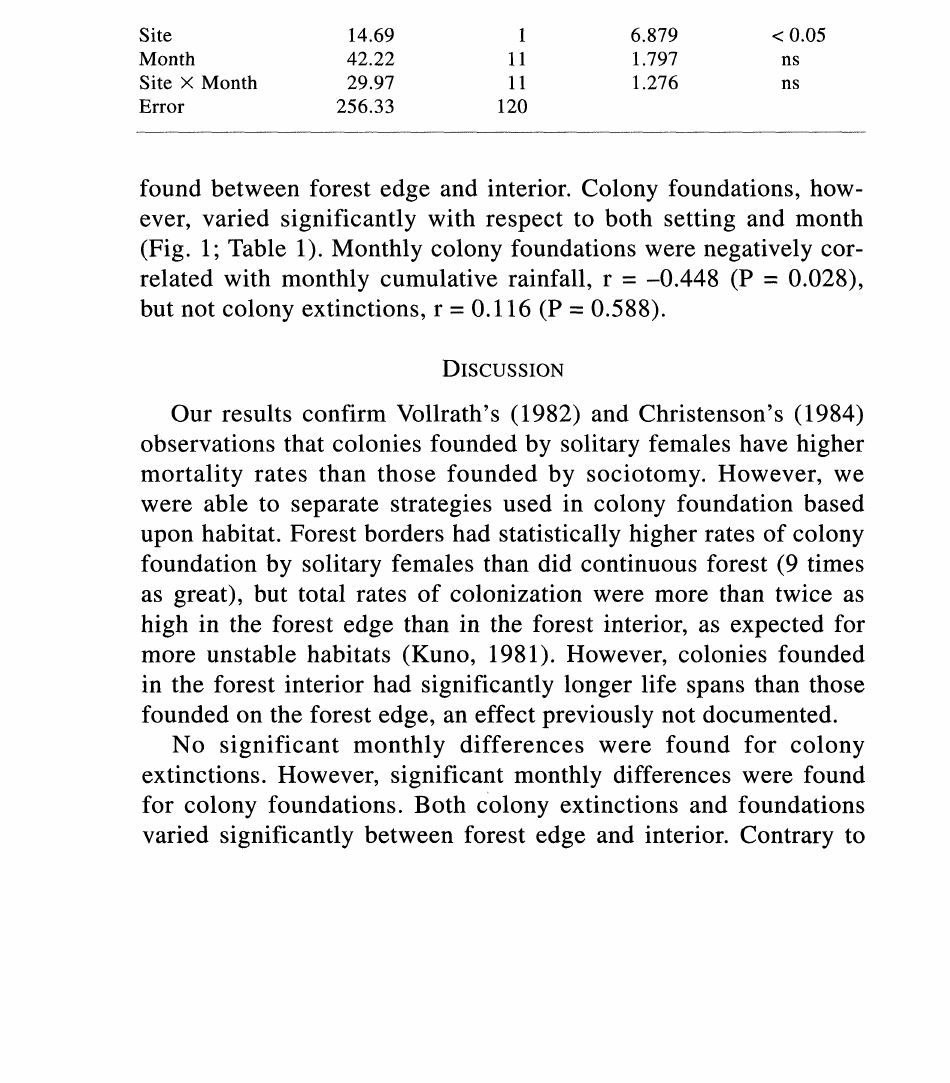
Table 1. The relation between colony extinctions and foundations with respect to site (forest interior or edge) and month. Source of